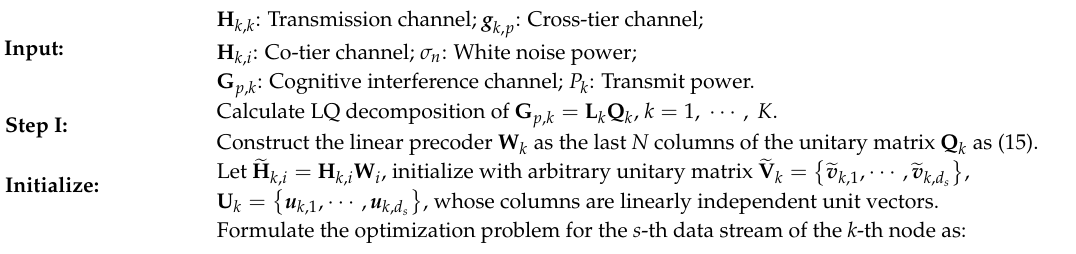
Algorithm 2 Partial cognitive IA (P-CIA) ( H k , k , H k , i , G p , k , g k